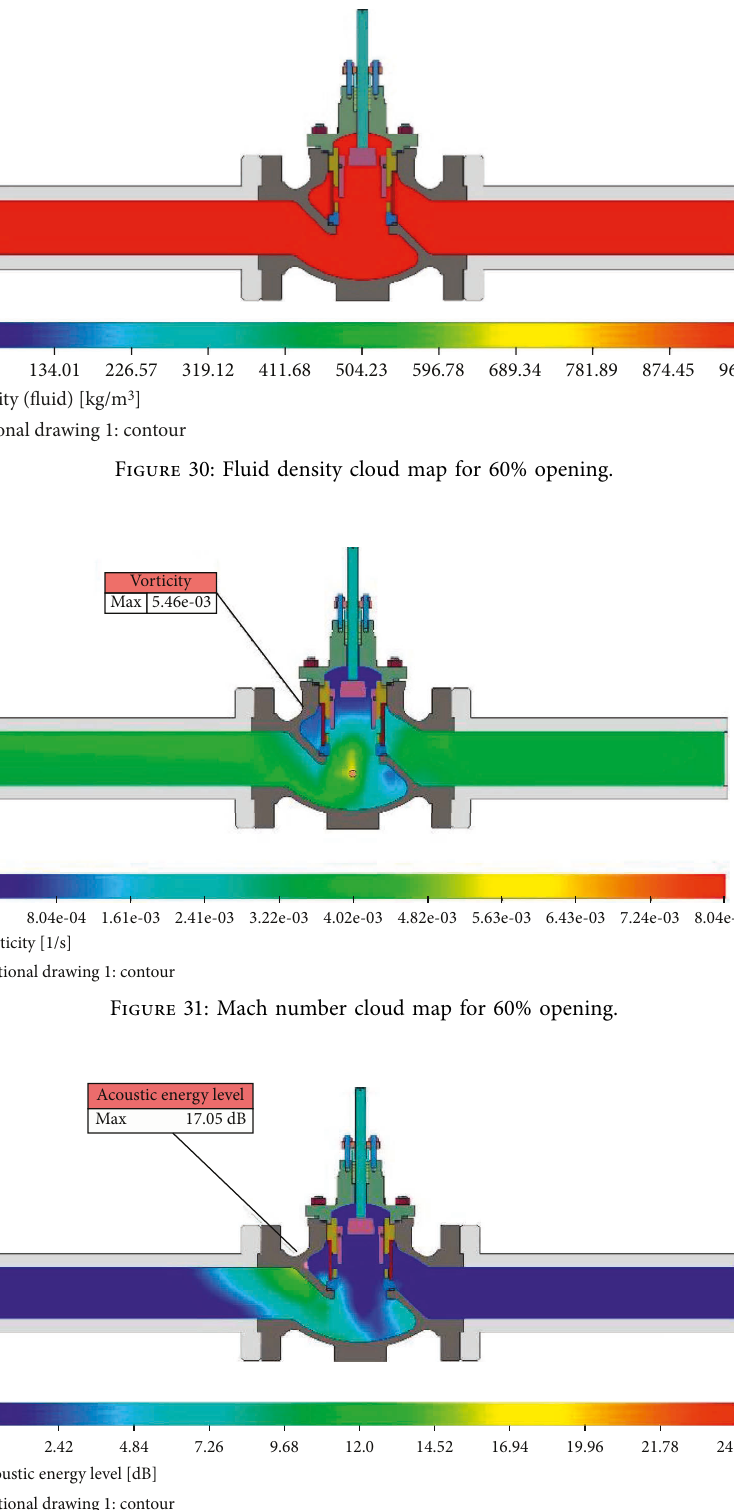
Figure 32: Acoustic energy level cloud map for 60% opening.